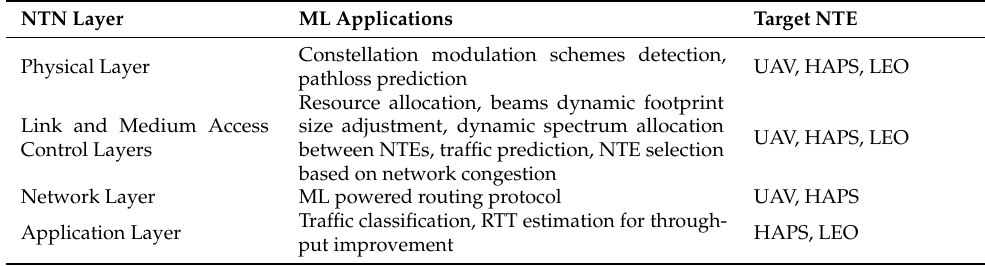
Table 5. ML applications for layers in the NTN protocol stack. NTN